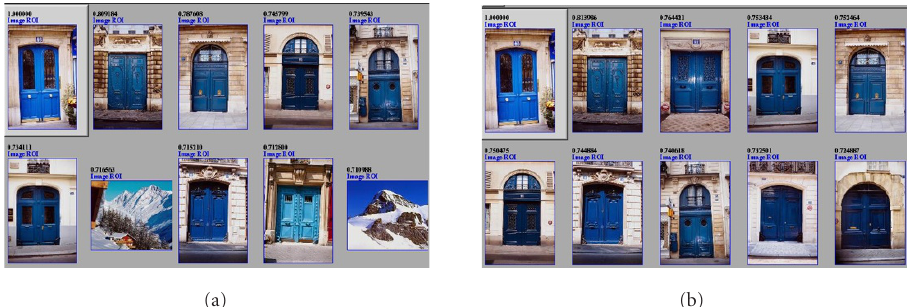
Figure 9: Results for a search of doors in the Corel database. Images are ranked by decreasing similarity from top to bottom, and from left to right. The query is the top-left-hand image. (a) Without spatial information. (b) With spatial information.